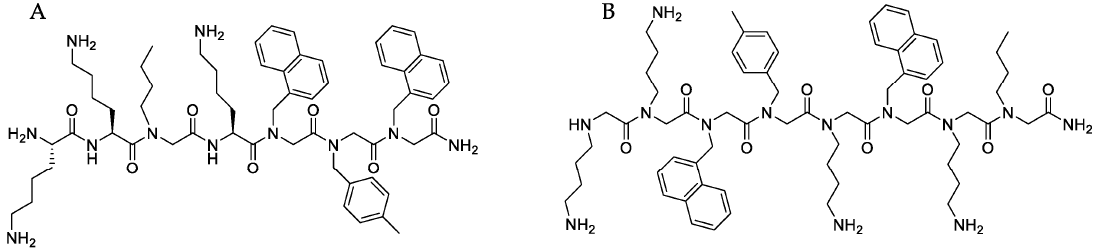
Figure 9. Chemical structures of synthetic peptidomimetic molecules such as a peptide–peptoid hybrid ( A ) and a peptoid ( B ); both highly active (MIC 2–4 µg/mL) for treating topical infections in dogs caused by Staphylococcus pseudintermedius. Reproduced from [152].